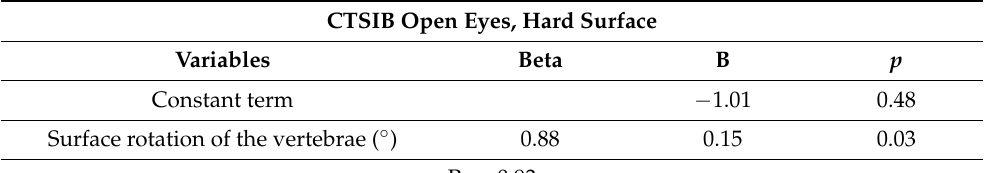
Table 4. Results of regression analysis for the Clinical Test of Sensory Integration and Balance in sub-tests: open and closed eyes, hard surface, and open and closed eyes, soft